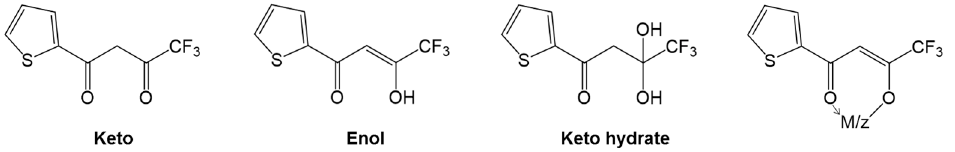
Figure 1. Structural formulas of the chelating extractant thenoyltrifluoroacetone (HTTA).